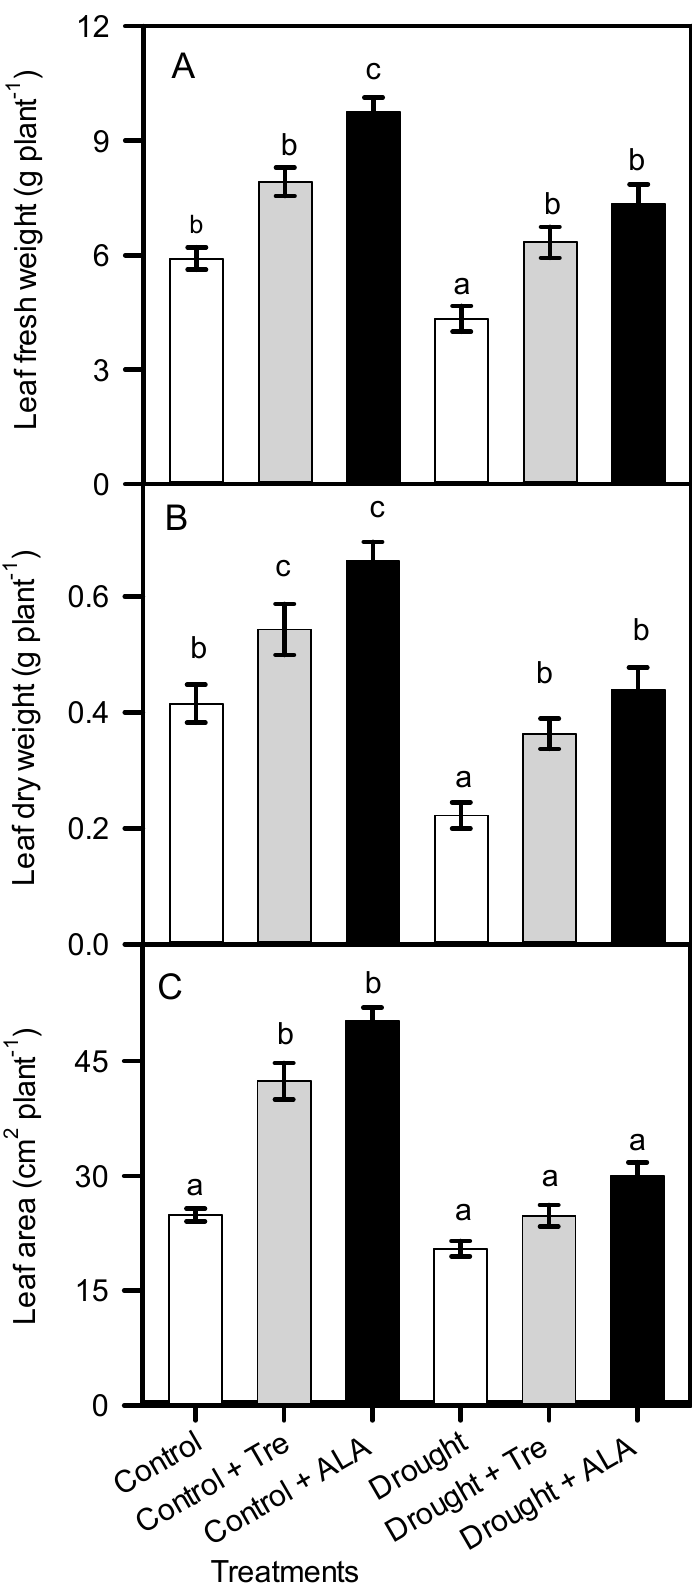
Figure 2. Leaf fresh weight ( A ), leaf dry weight ( B ), and leaf area ( C ) of well-watered (100% FC, Control) and drought-stressed (65% FC, Drought) Alpinia zerumbet treated with foliar applications of water alone, 25 mM trehalose (Tre) or 10 mg L − 1 5-aminolevulinic acid (ALA). Values are means ± S.E. ( n = 6). Different letters above the bars indicate significant differences based on LSD at p < 0.05.